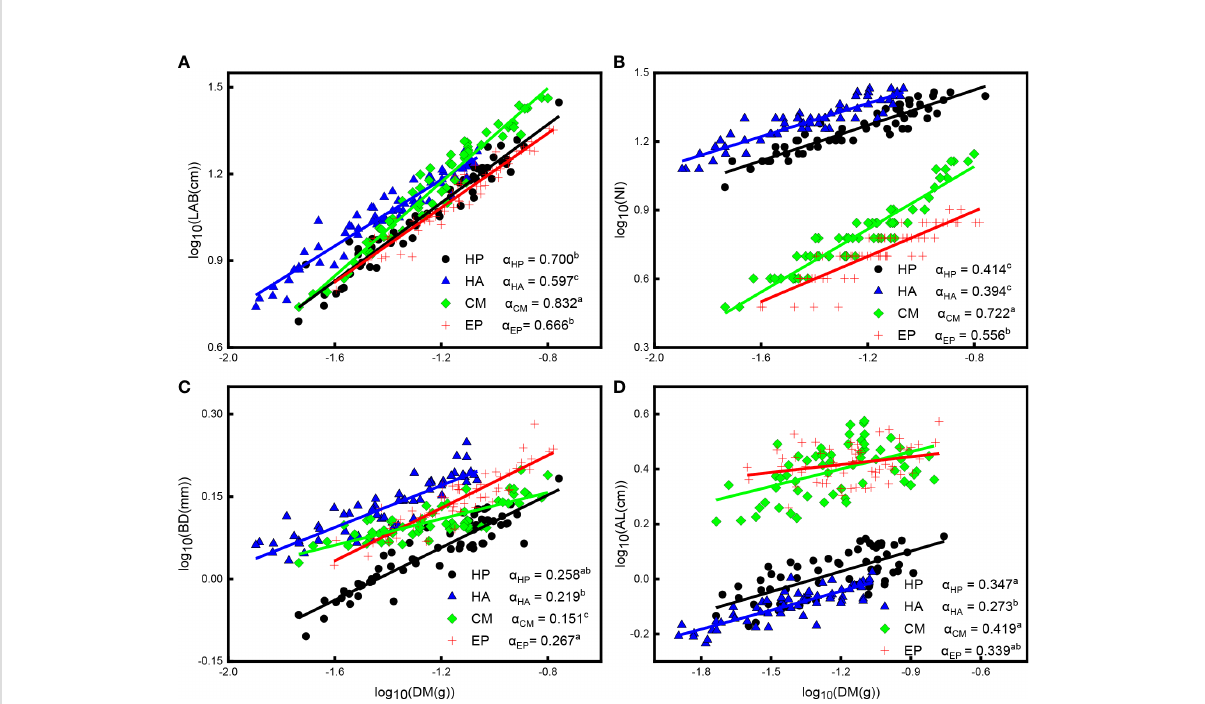
FIGURE 4 Allometric relationships among LAB, NI, BD, AL, and DM offour desert shrubs. (A) The relationship between LAB and DM, (B) The relationship between NI and DM, (C) The relationship between BD and DM, (D) The relationship between AL and DM. Species: HP = Haloxylon persicum , HA = Haloxylon ammodendron , CM = Calligonum mongolicum , and EP = Ephedra przewalskii ; Functional traits: LAB = Length of assimilative branches, NI = Number of internodes, DM = Dry mass of assimilative branches, BD = Average basal diameter of assimilative branches, and AL = Average length of the fi rst three internodes of assimilative branches; Different lowercase letters in the upper right-hand corner of the plot of scaling exponents ( a ) represent signi fi cant differences (P <